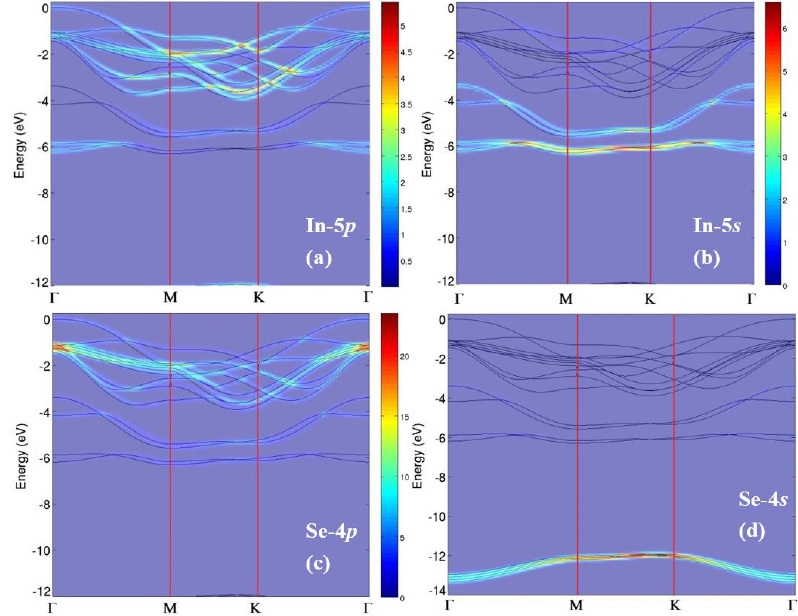
Figure 4. Theoretical band structure projected to ( a ) In-5p; ( b ) In-5s; ( c ) Se-4p; and ( d ) Se-4s atomic orbitals. The intensity of the various bands is reported in a color scale, whose legend is displayed in the right part of panels ( a , b ) and between panels ( c , d ). Reproduced with permission from Ref.